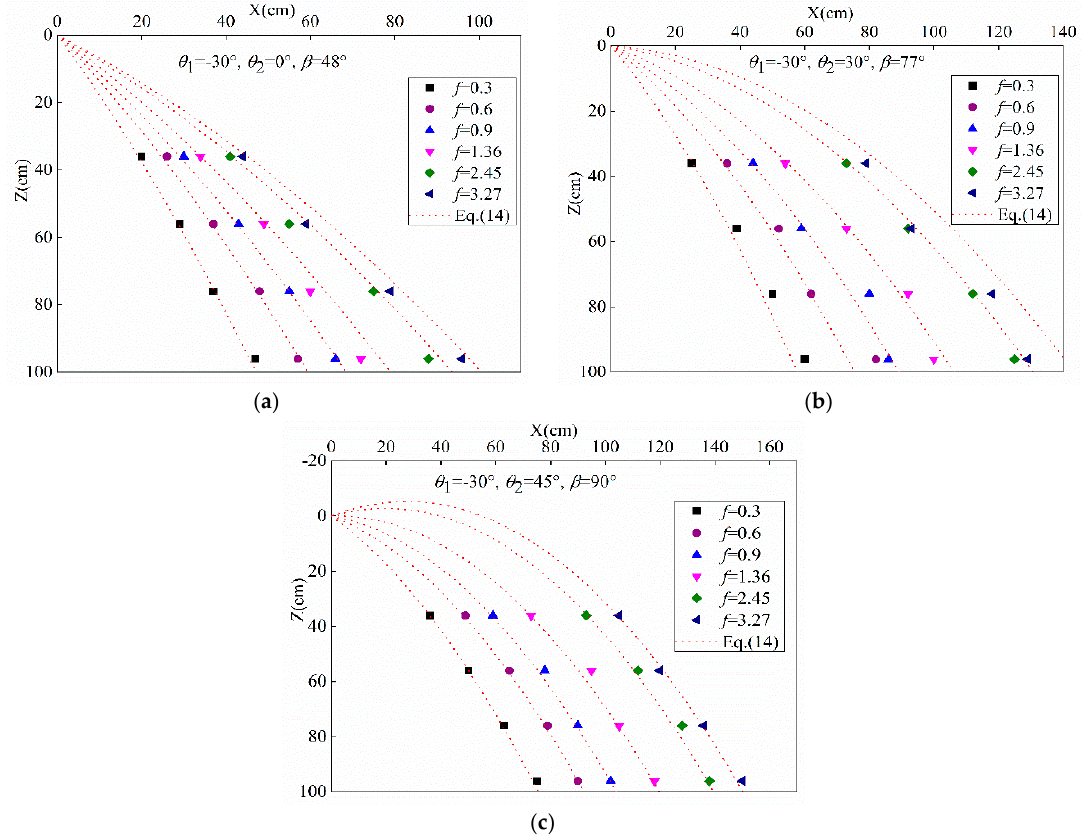
Figure 10. Comparison of experimental and calculated values of the maximum rainfall intensity points. ( a ) θ 1 = − 30°, θ 2 = 0°, and β = 48°; ( b ) θ 1 = − 30°, θ 2 = 30°, and β = 77°; ( c ) θ 1 = − 30°, θ 2 = 45°, and β = 90°.